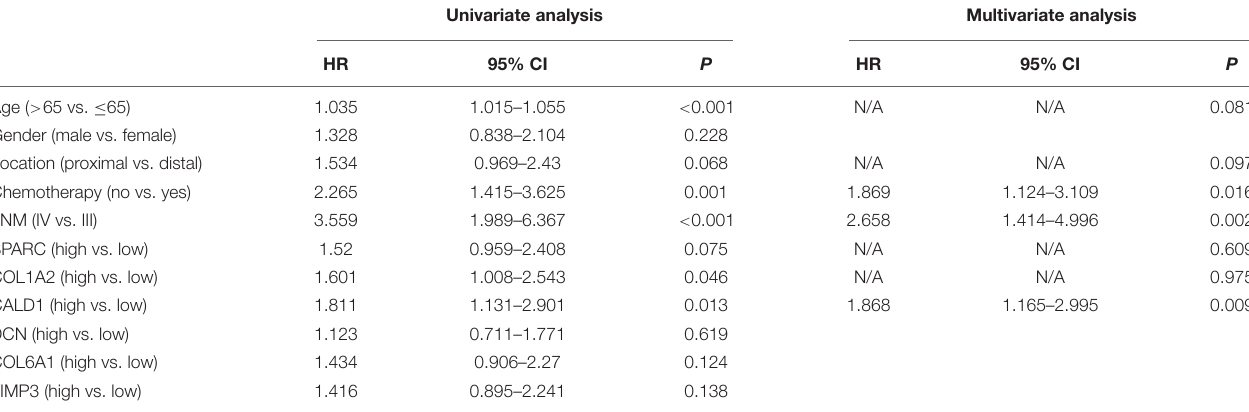
TABLE 2 | Univariate and multivariate Cox proportional hazard regression analysis on OS in GSE39582. Univariate analysis Multivariate